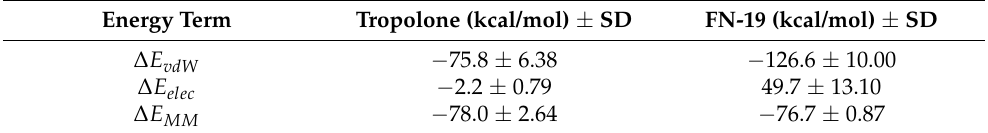
Table 3. Different MM/PBSA terms for the relative change in the enthalpy of the tyrosinase binding site in complex with tropolone and FN-19 inhibitor at 300 K. Energy Term Tropolone (kcal/mol) ±